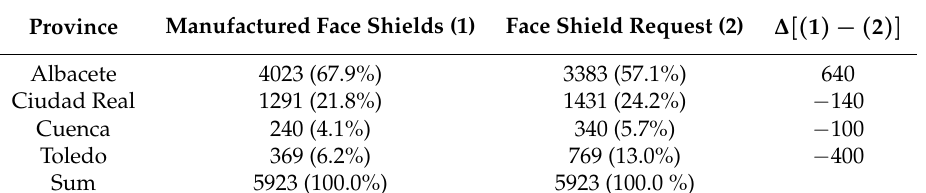
Table 5. Production and requesting of face shields per province in the central distribution model.